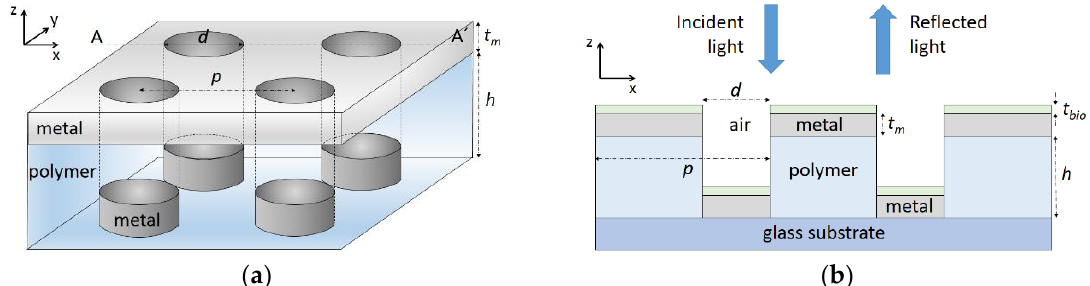
Figure 1. ( a ) Schematics of the modeled Al/polymer multilayered square lattice plasmonic crystal label-free biosensor; ( b ) Cross-sectional view along AA’ including a biolayer of thickness t bio adhered on Al metal surfaces. Light along the − z axis impinges on the device, and the spectral distribution of normally reflected light is computed.